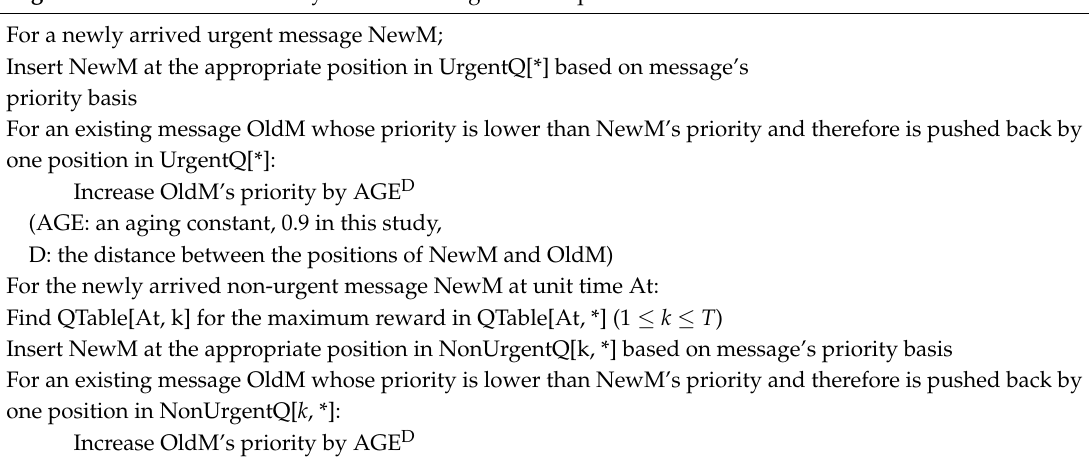
Algorithm 1. Insertion of newly arrived message into its queue For a newly arrived urgent message